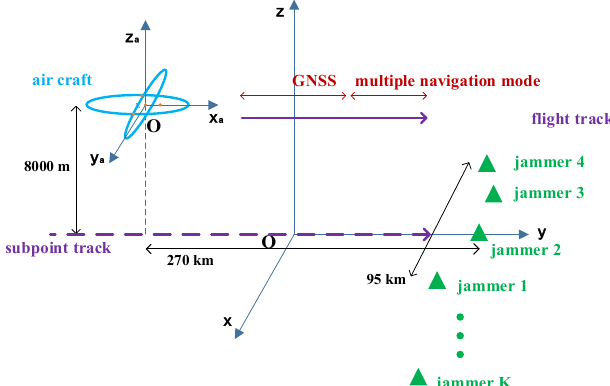
Figure 6. Sketch map of airborne scenario.